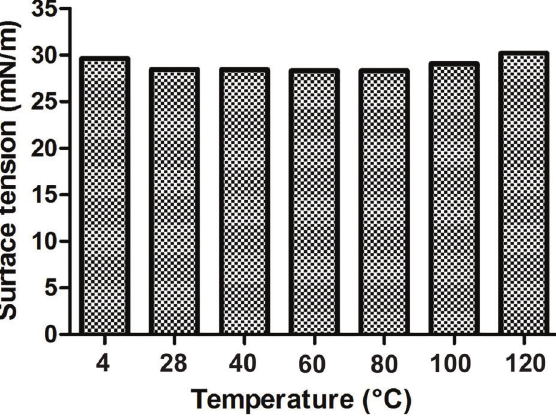
Figure 4. In fl uence of pH on the surface tension of the biosur- factant after 96 h of fermentation.